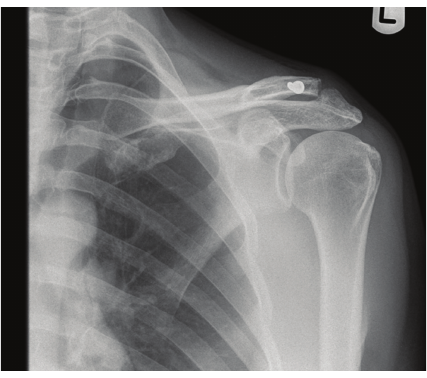
Figure 9: Postoperative AP radiograph showing the reduced joint.